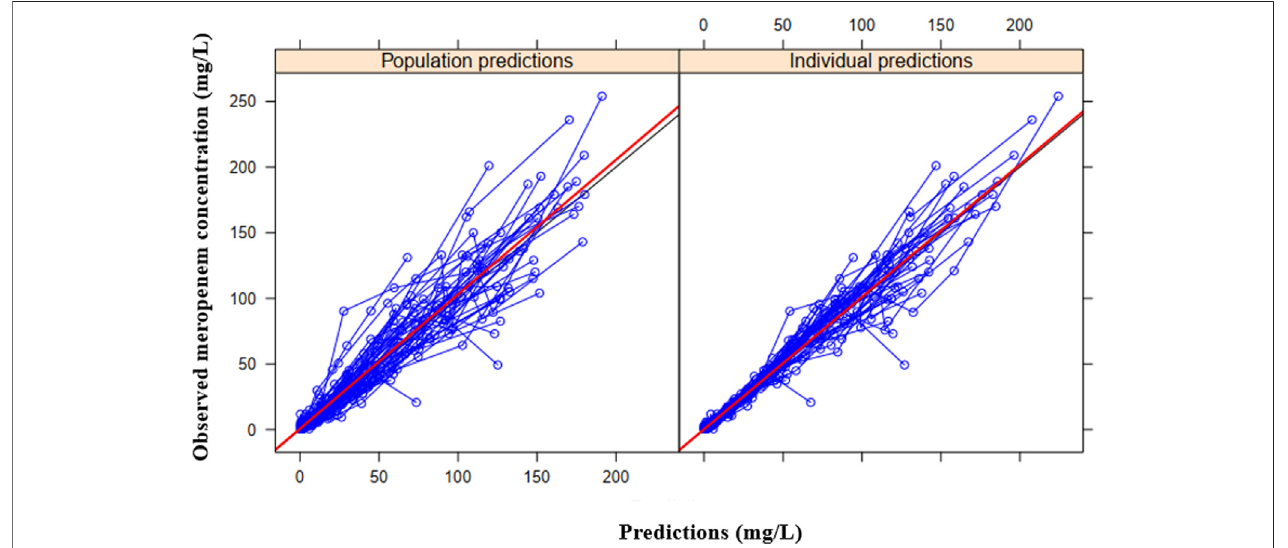
FIGURE 3 | Basic goodness-of- fi t plots of the fi nal model showing the observed meropenem concentration vs. the individual predicted concentration (right) or population predicted concentration (left) . The observed and predicted concentrations are from the 49 individuals in the study.